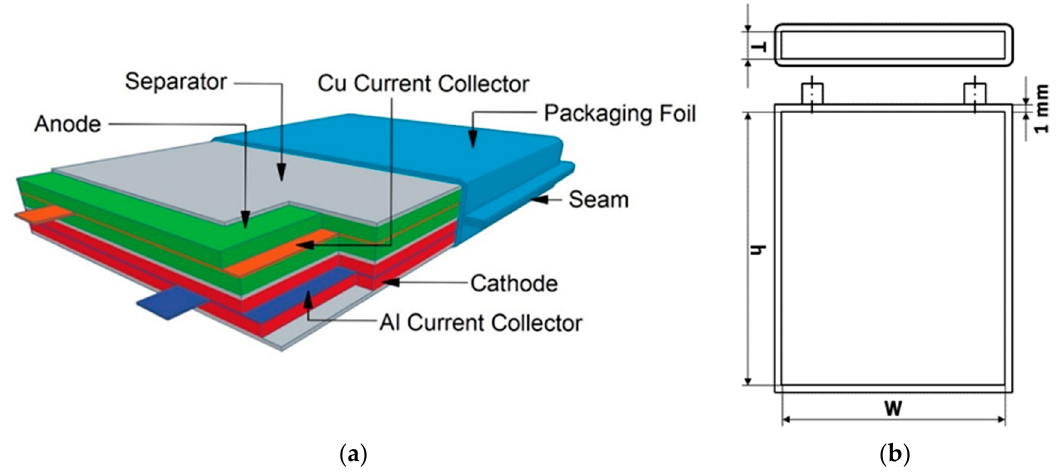
Figure 1. ( a ) Basic cell stack; ( b ) Technical drawing of the cell dimensions with default model